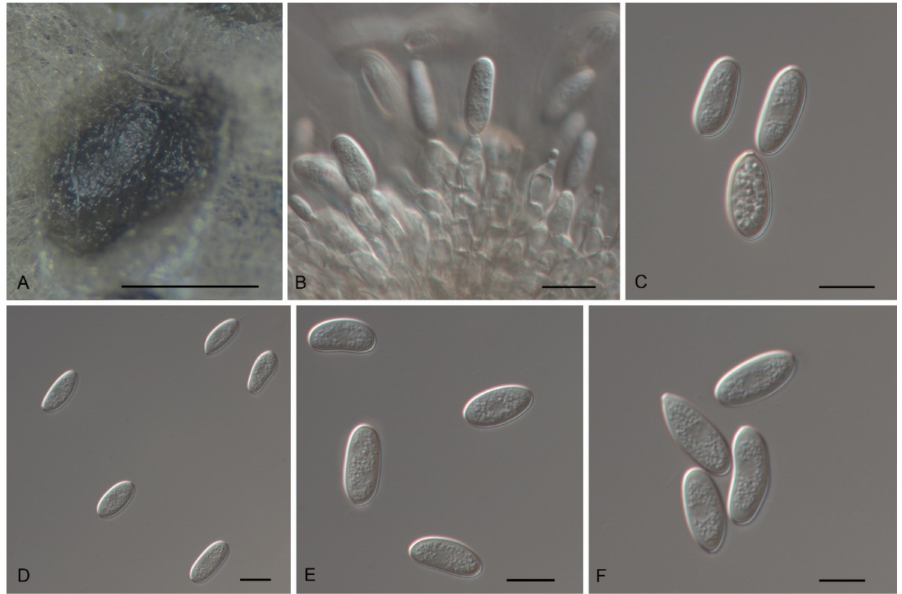
Figure 10. The morphology of Tubakia koreana (CFCC 54968). ( A ) Conidioma formed on PDA; ( B ) Conidiogenous cells giving rise to conidia; ( C – F ) Conidia. Scale bars: ( A ) = 100 µ m; ( B – F ) = 10 µ